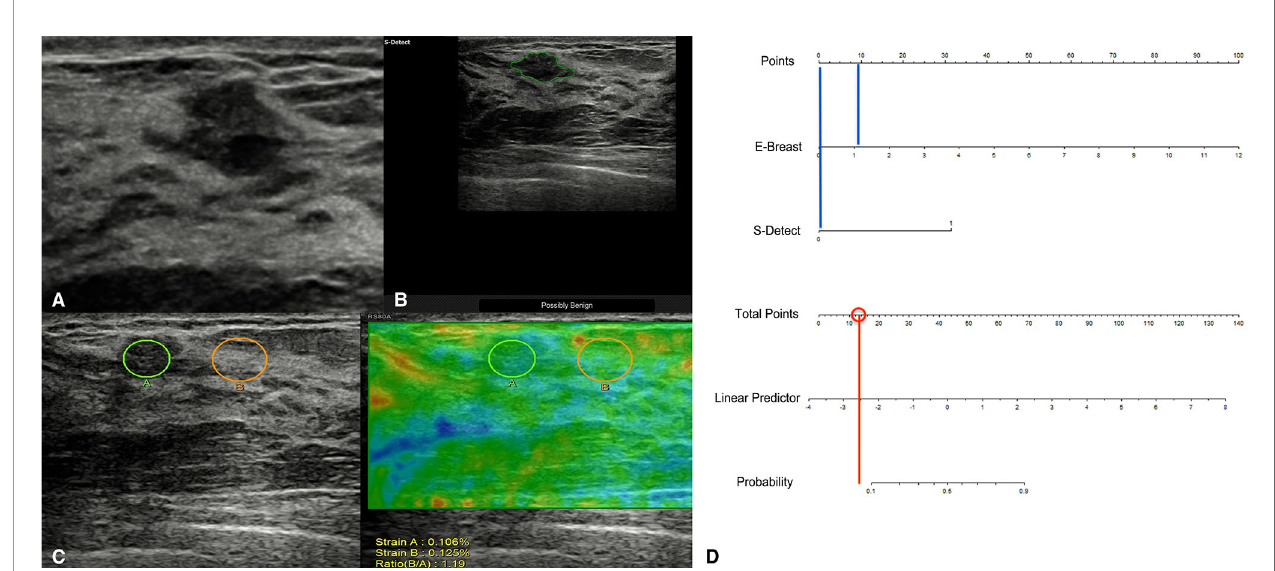
FIGURE 5 | A typical case of a 45-year-old patient with a breast lesion detected and classi fi ed as BI-RADS 4a by screening ultrasound (US) ( A ; grayscale of the US). S-Detect classi fi ed it as possibly benign (B) , and its strain ratio (SR) was 1.19 (C) . According to the nomogram, the point for SR result was near 10, and the point for S-Detect was 0 (blue vertical lines), thus acquiring a total score of 10 for the lesion and a predictive percentage of less than 0.1 (D) . The pathological result for the lesion was